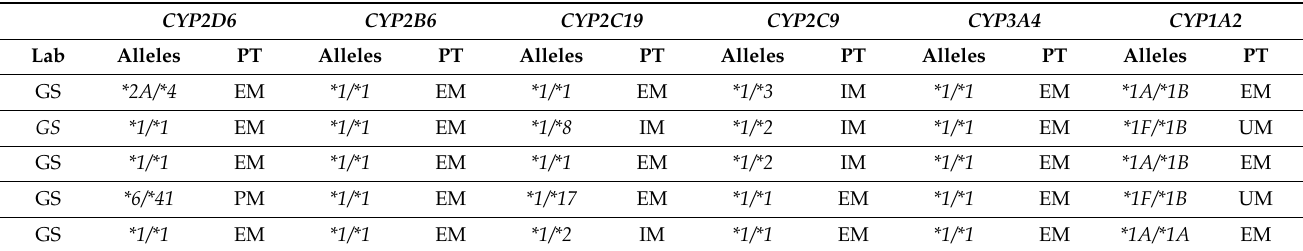
Table A4. Pharmacogenetic data for cytochrome P450 enzymes in PWS Unspecified cohort (DNA methylation positive, subtype unspecified): Testing laboratory, CYP genotype, and CYP phenotype.